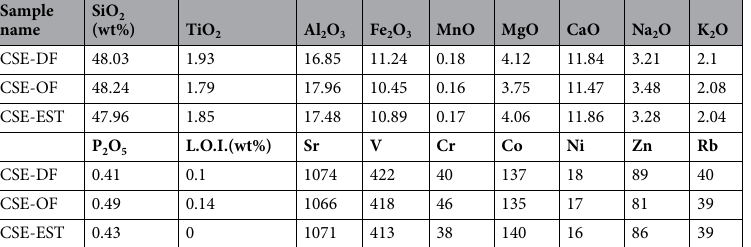
Table 2. Major element (wt%) and minor elements analyses of the lava erupted on 28 December 2014. CSE-DF and CSE-OF have been emitted by the south-western branch of the eruptive fracture, whereas the CSE-EST has been erupted by the north-eastern branch of the eruptive